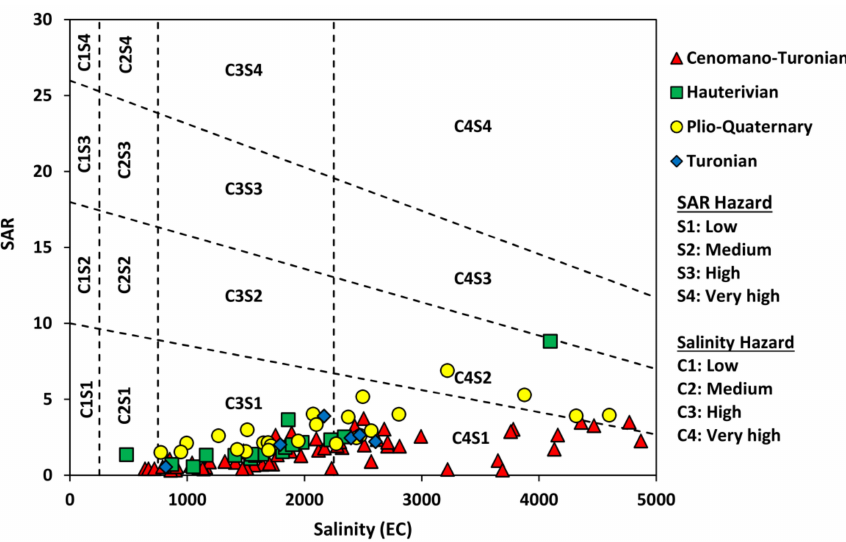
Figure 18. United States Salinity Laboratory (USSL) salinity hazard diagram of the analyzed